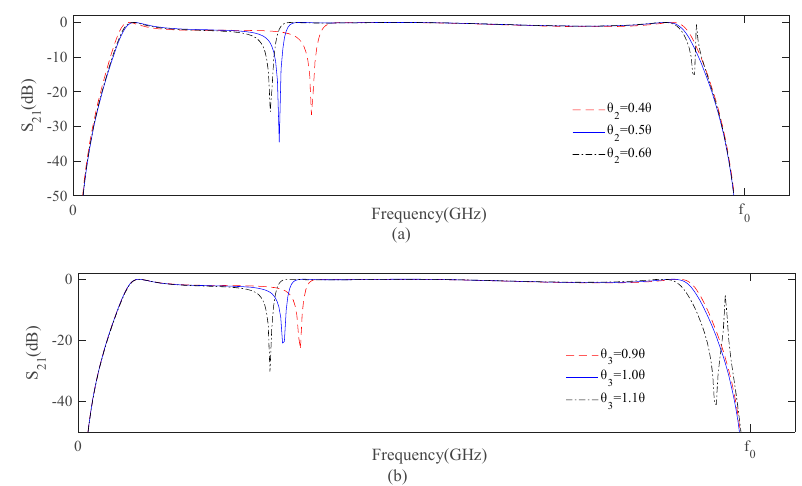
Figure 4. Simulated frequency responses of the proposed CLCSR filter with varied parameters, ( a ) θ 2 and ( b ) θ 3 .